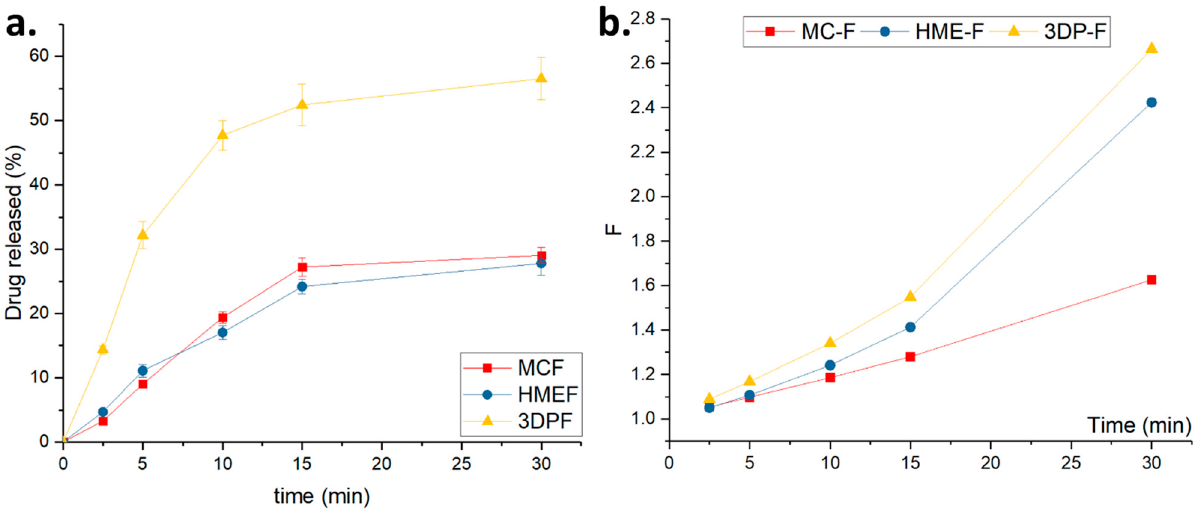
Figure 12. ( a ) The drug release profiles and ( b ) the Fickian diffusion factor, F, of the MC-F, HME-F, and 3DP-F in SS.